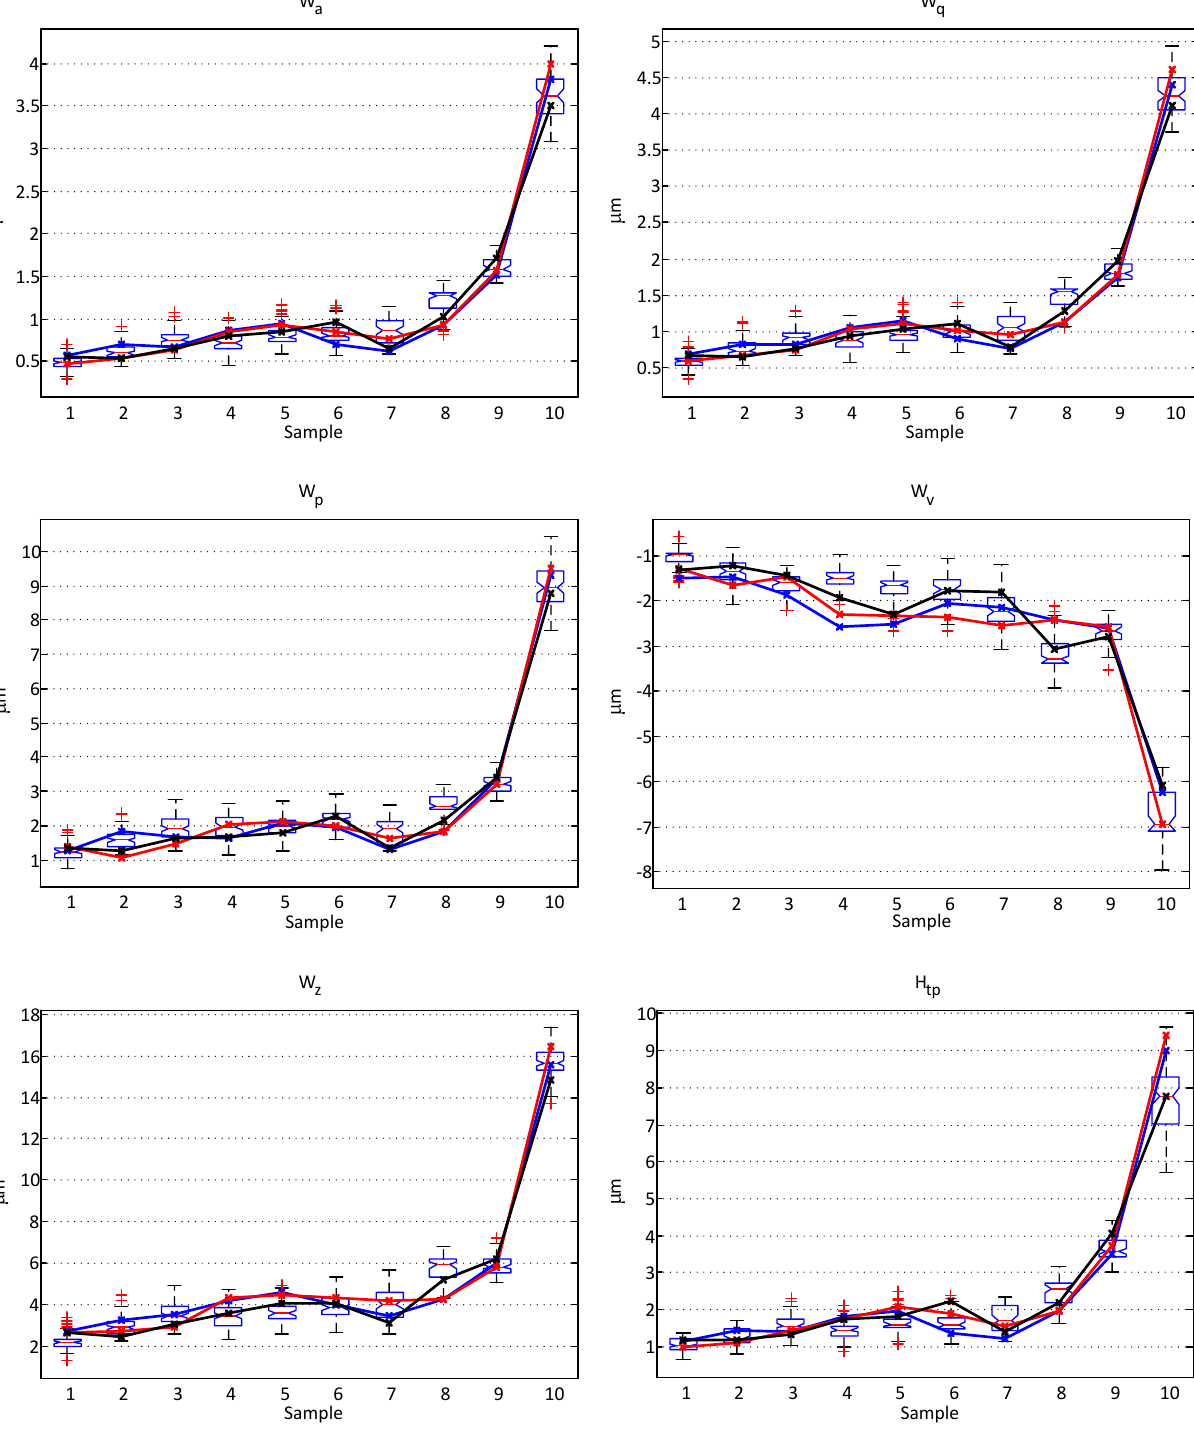
, W , W , W , W , and H using a q p v z tp